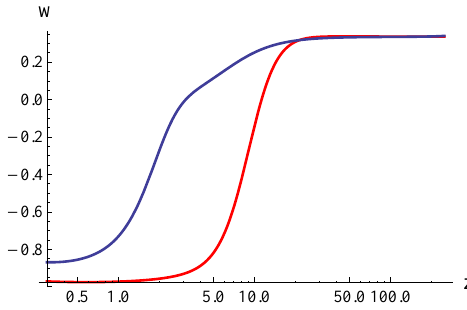
Figure 1. Plot of w against the redshift z , from current time up to recombination. For the blue line, the coupled system of non-linear differential Equations (10), (11) and (15) has been solved numerically for g = 10 − 1 and λ = 1, and the initial conditions on the functions H ( 0 ) = 10 − 42 GeV and φ ( 0 ) (cid:39) π ( 0 ) (cid:39) f D = 10 − 3 eV, and on their derivatives φ (cid:48) ( 0 ) (cid:39) π (cid:48) ( 0 )= 10 − 5 ( eV ) 2 . Transition from DE to (dark sector) radiation happens for z (cid:39) 2 in the blue line. The plotted red line entails a coupling constant g , the value of which is one order of magnitude smaller than in the case of the blue